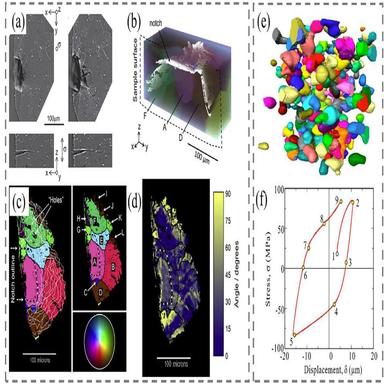
Damage fracture behavior during deformation using DCT technique: (a) reconstructed sections after 500 and 10,500 fatigue cycles; (b) 3D rendering showing the crack and the grains; (c) plan view of crack; (d) deviation between the crack plane and the crystallographic basal plane . (e) Reconstructed grain shapes by DCT; (f) DCT measurements at several stress levels during the cycle .